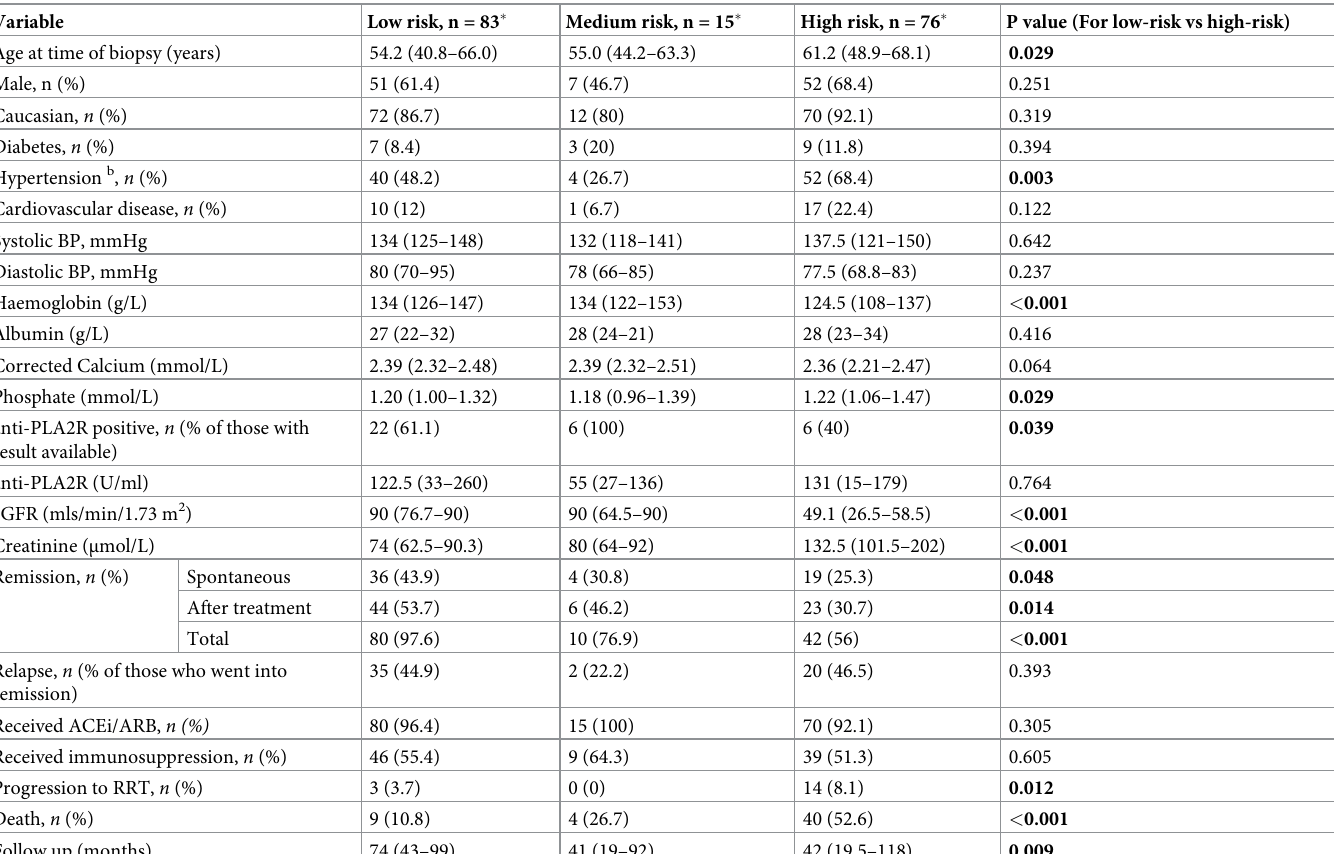
Table 5. Baseline characteristics and outcomes according to risk of progression as per KDIGO (low/ medium/